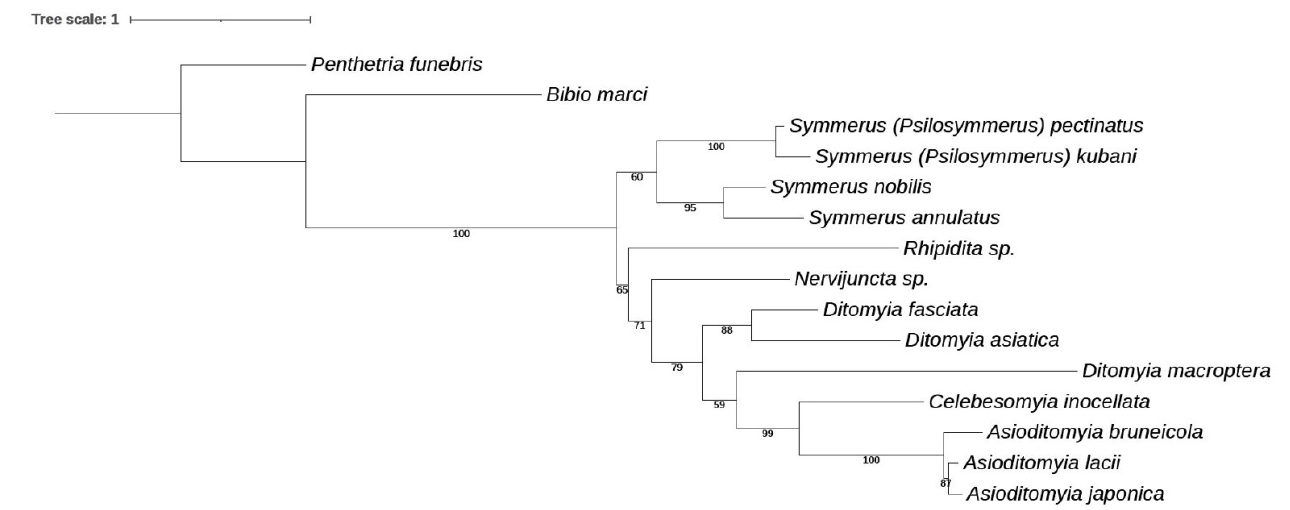
Figure 12. Phylogenetic relationships (Maximum Likelihood hypothesis) among the species of Ditomyiidae based on two DNA markers (28S and COI).